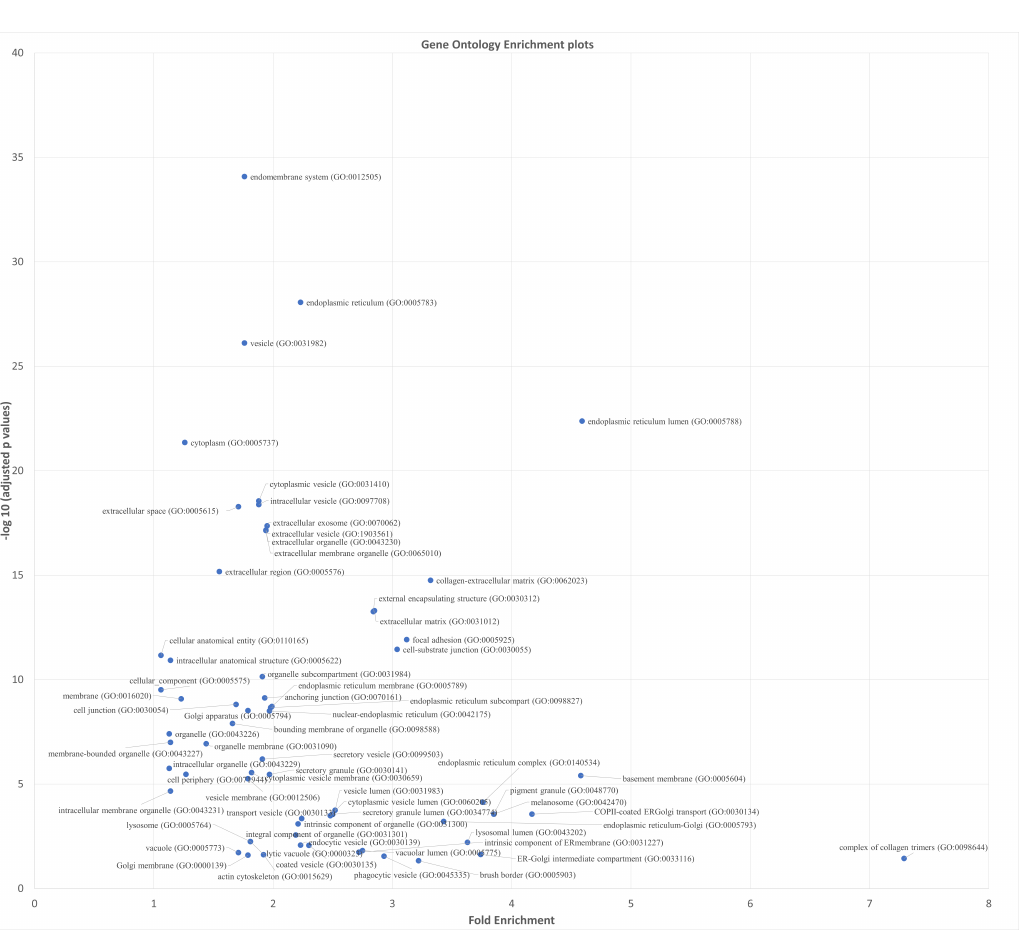
Figure 2. Scatter plots of Gene Ontology (GO) cellular component (CC) for genes upregulated in hypoxia. X-axis is the fold enrichment and Y-axis is the − log 10 scale of adjusted p-values of the GO CC term. Both by fold enrichment and low p-values the components of the endoplasmic reticulum are significantly upregulated in hypoxia.